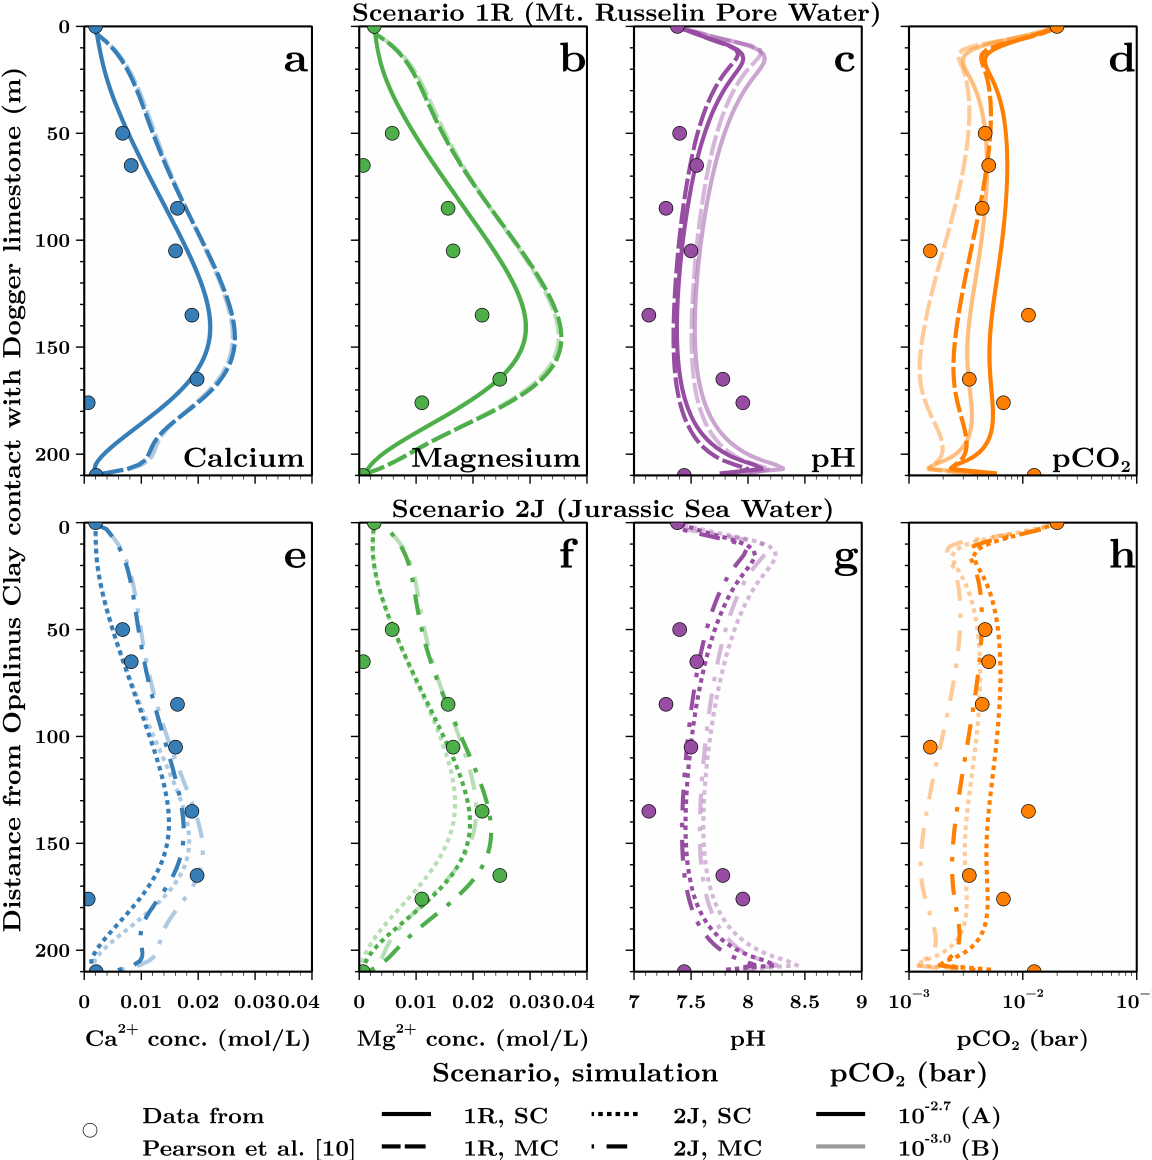
Figure 6. Pore water profiles of Ca 2 + ( a , e ), Mg 2 + ( b , f ), pH ( c , g ) and pCO 2 ( d , h ) were confirmed using the initial concen- trations according to scenario 1R (a-d) and scenario 2J (e-h) applying SC (solid and dotted lines) as well as MC diffusion (dashed and dash-dotted lines). Initial pore waters were equilibrated with the carbonates, calcite, dolomite, and siderite, as well as pyrite for pCO 2 of 10 − 2.7 bar (A) and 10 − 3 bar (B). Total simulation time was six million years with the footwall aquifer only being active for the last 0.5 million years. The data stem from borehole analysis at the underground laboratory Mont Terri